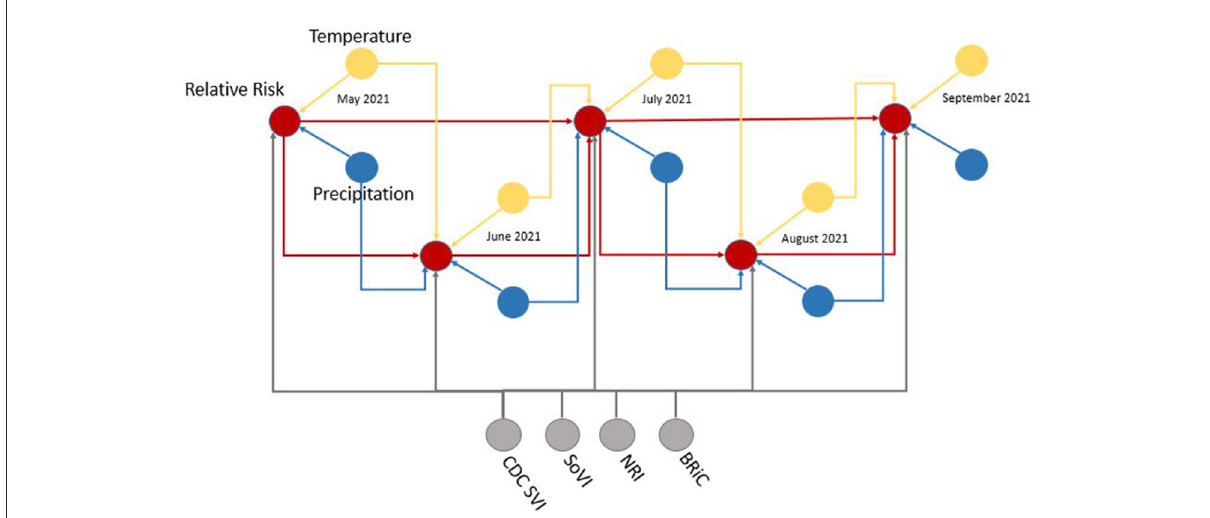
FIGURE5 Example subset of recurrent structure of the DBN; yellow, temperature nodes; blue, precipitation nodes; gray, social vulnerability/resiliency index/NRI nodes; red, contemporaneous target, relative risk. For simplicity this DAG makes no distinction between predicted temperature from NEX-DCP30 and observed temperature from NLDAS. As the modeling moves forward in time, the NEX-DCP30 values are replaced by the NLDAS observations once the realization is available.